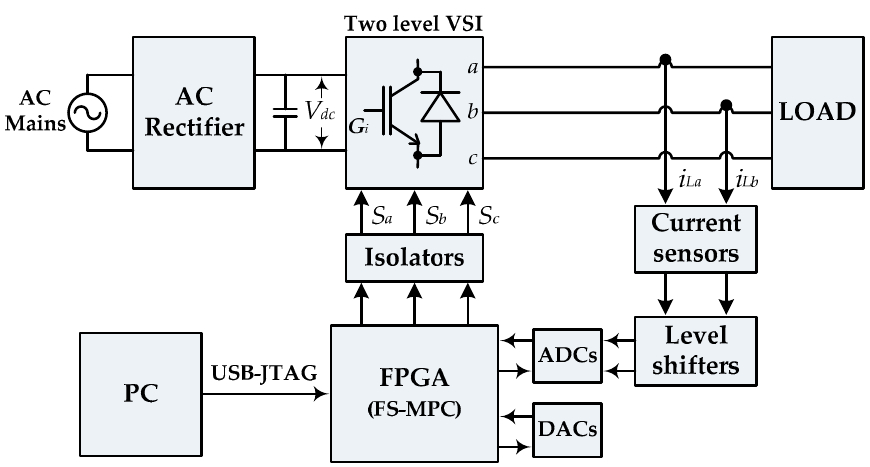
Figure 10. Block diagram of experimental setup.